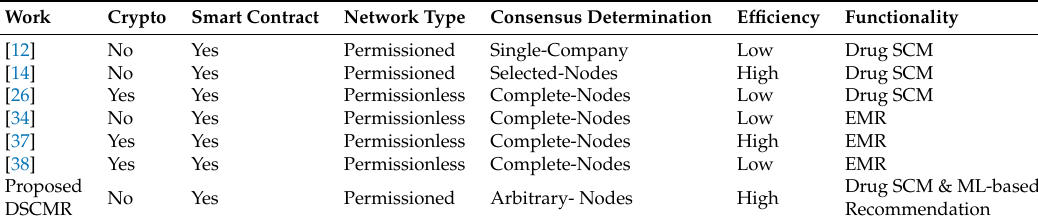
Table 4. Comparison of proposed system with existing